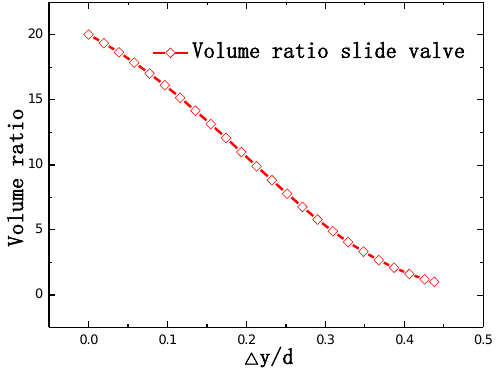
Figure 9. Volume ratio vs. ∆𝑦/𝑑 1 o f volume ratio slide valve.